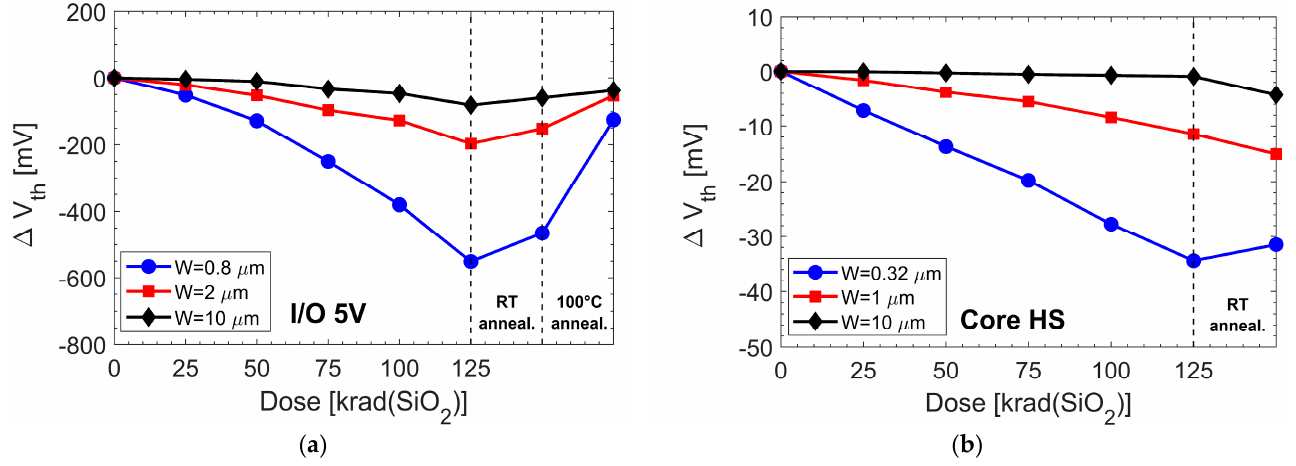
Figure 5. ∆ V th is plotted as a function of the dose for devices with different channel widths, and the channel length is constant at 10 µ m. Transistors irradiated up to 125 krad(SiO 2 ), annealed at room temperature for 24 h and then annealed at 100 ◦ C for 24 h (only I/O devices). All measurements are carried out at room temperature in linear regime ( V ds = 0.1 V). ( a ) I/O 5V devices and ( b ) core HS